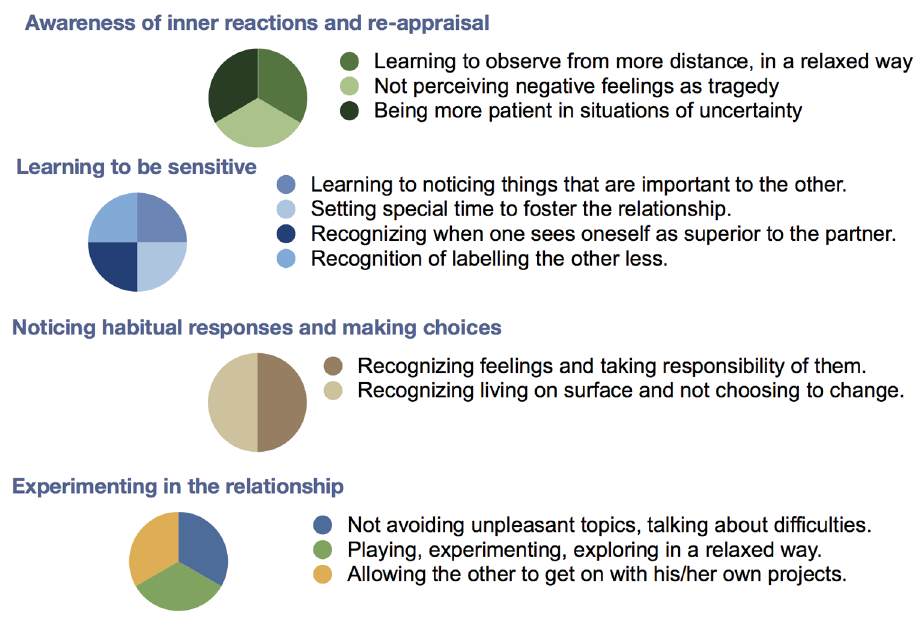
Figure 1. Map of themes on self-regulation in couple